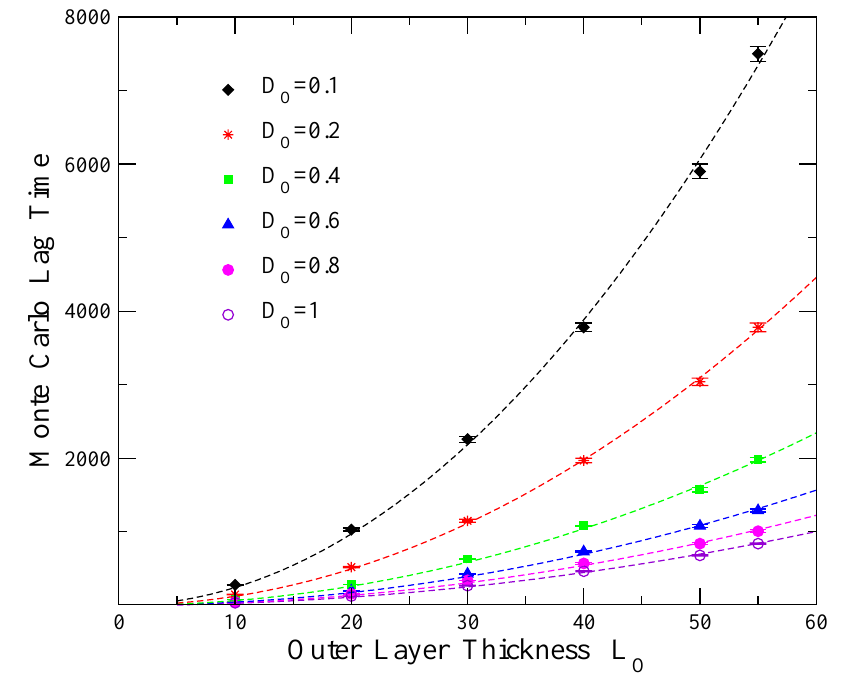
Figure 4. Dependence of lag time on the thickness L O of the outer layer. Different symbols show the lag time of the Monte Carlo simulations as a function of L O , for different values of outer layer’s drug diffusion coefficient D O according to the labelling indicated in the plot. The other parameters are L = 60 , L x = L y = 20 and C 0 = 0.5 . Error bars represent mean-value errors calculated through 100 Monte Carlo realizations. Dashed lines show fittings with a simple quadratic function, t lag = α ∙ L O2 .